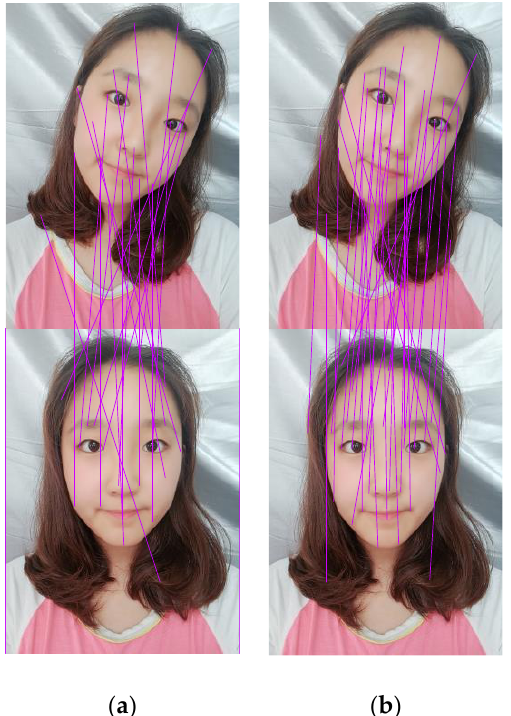
Figure 15. Comparison of matching effect using the self-collection face database: ( a ) SIFT Model; ( b ) SIFT/RITF Model.